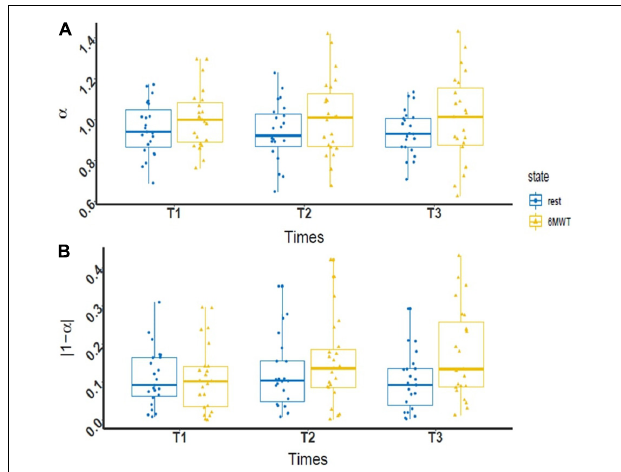
FIGURE 2 | Box plot of R-R interval fractal exponent values during PR. (A) Evolution of the level of complexity ( α ) at rest (blue dot) and during 6MWT (yellow triangle) throughout the PR program ( n = 23); (B) evolution of the deviation from maximal complexity (|1- α |) at rest (blue dot) and during the 6MWT (yellow triangle) throughout the PR program ( n = 23). In each boxplot, the data are represented from bottom to top by the minimum value, the first quartile, the median, the third quartile, and the maximum value. A two-way ANOVA revealed a significant difference between complexity at rest and during the 6MWT for the two fractal exponents [ F (1,21) = 0.09, p = 0.91, η 2 = 0.001 and F (1,21) = 2.51, p = 0.09, η 2 = 0.03, respectively].